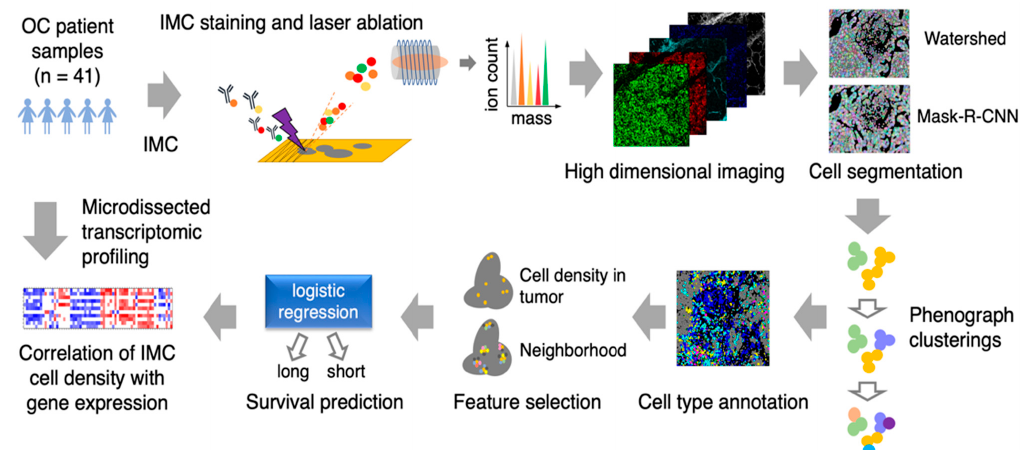
Figure 1. Schematic of imaging mass cytometry (IMC) acquisition of multiplexed images from 41 ovarian cancer patient samples and the spatioimageomics (SIO) pipeline. The SIO pipeline includes cell segmentation by a mix of the mask-R-CNN method trained on the outputs of the watershed method, phenograph clusterings, cell subtype annotation and visualizations, cell density and nearest-neighborhood feature selection, survival prediction by logistic regression, and integration of IMC cell density with transcriptomes from location-specific microdissected epithelial and fibroblastic stromal compartments of HGSC patient tissue samples.